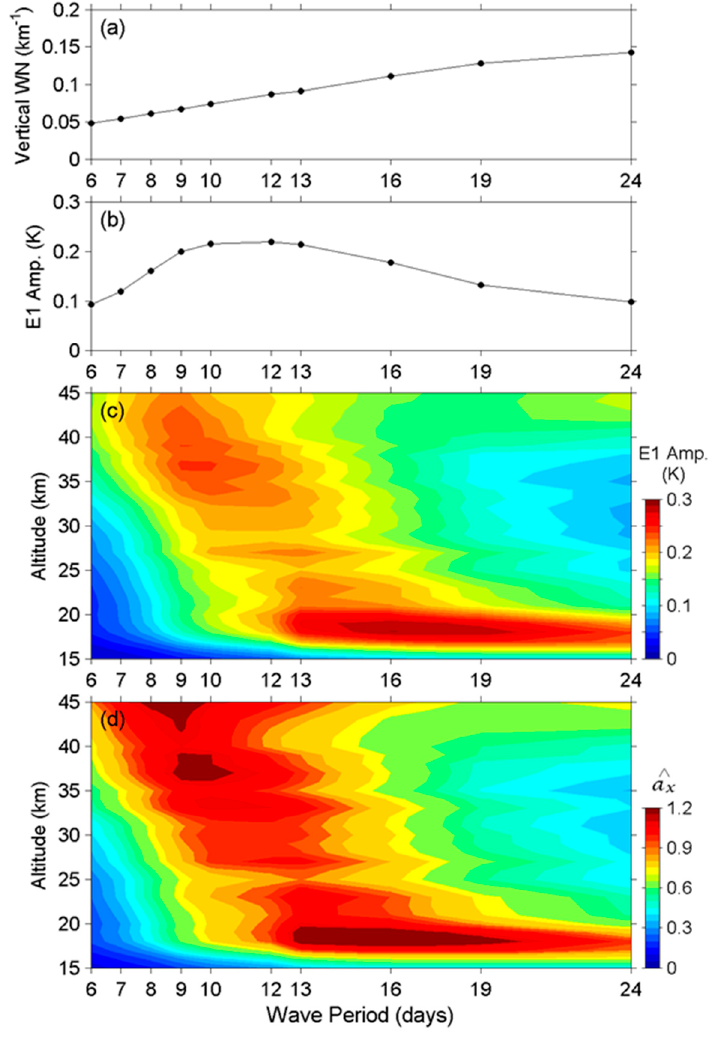
Figure 9. ( a ) Vertical wavenumbers and ( b ) amplitudes of the E1 waves with 6–24 day periods at a 30 km altitude. ( c ) Amplitudes of E1 waves and ( d ) normalized zonal acceleration as functions of period and altitude.